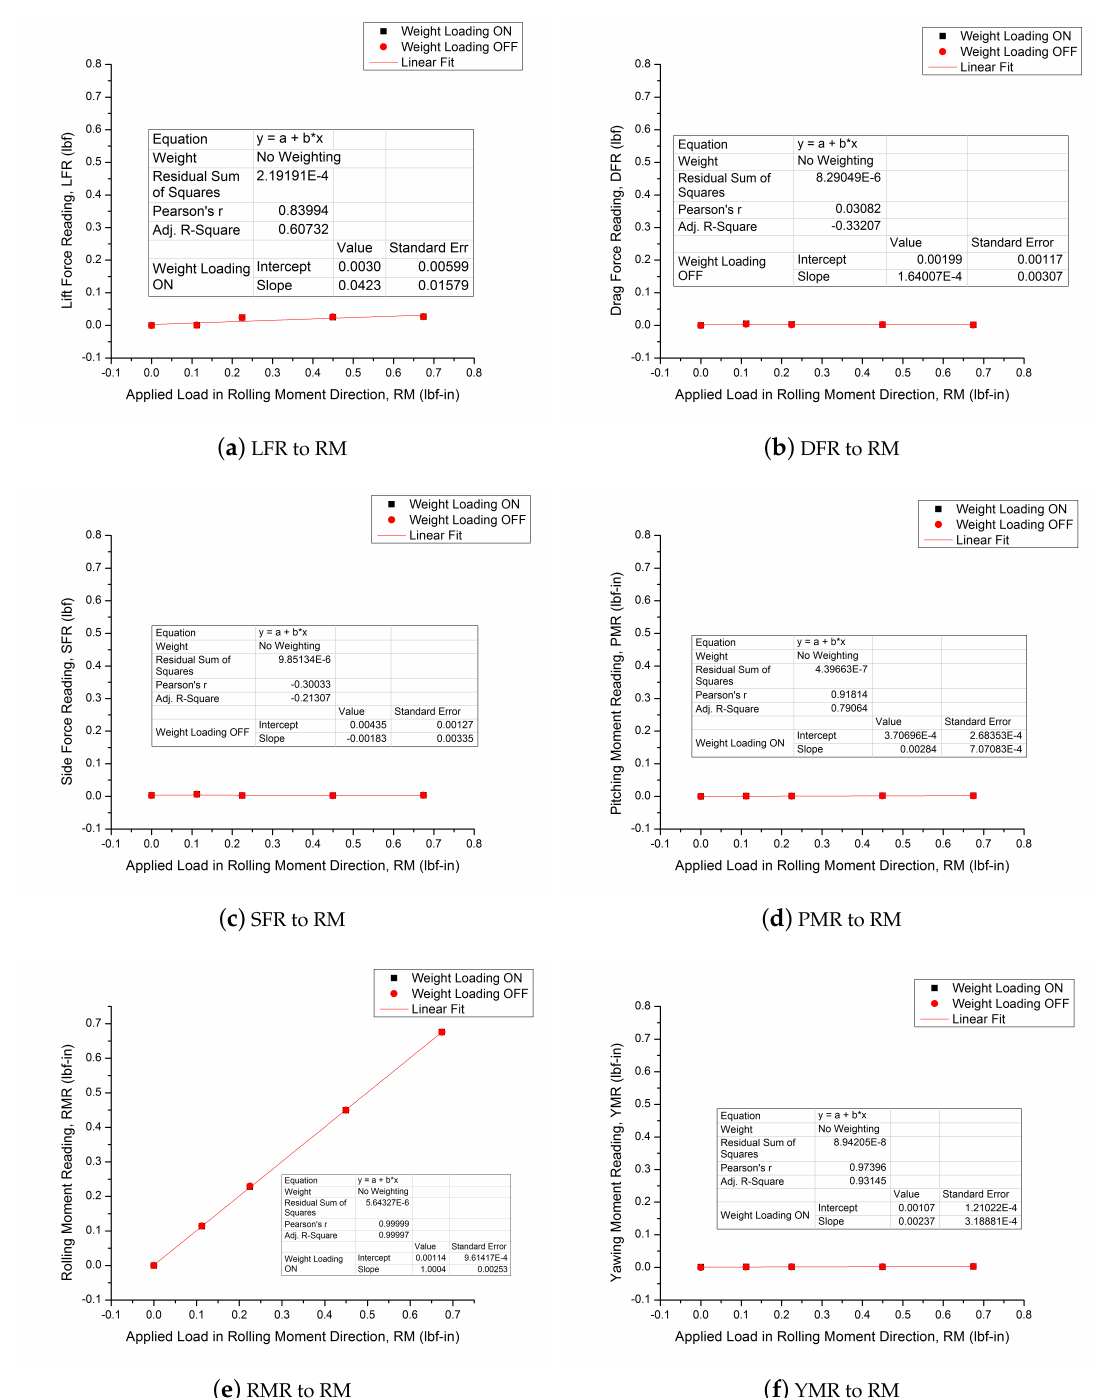
Figure A5. Experimentally obtained wind tunnel pyramidal balance interactions upon applied load in rolling moment